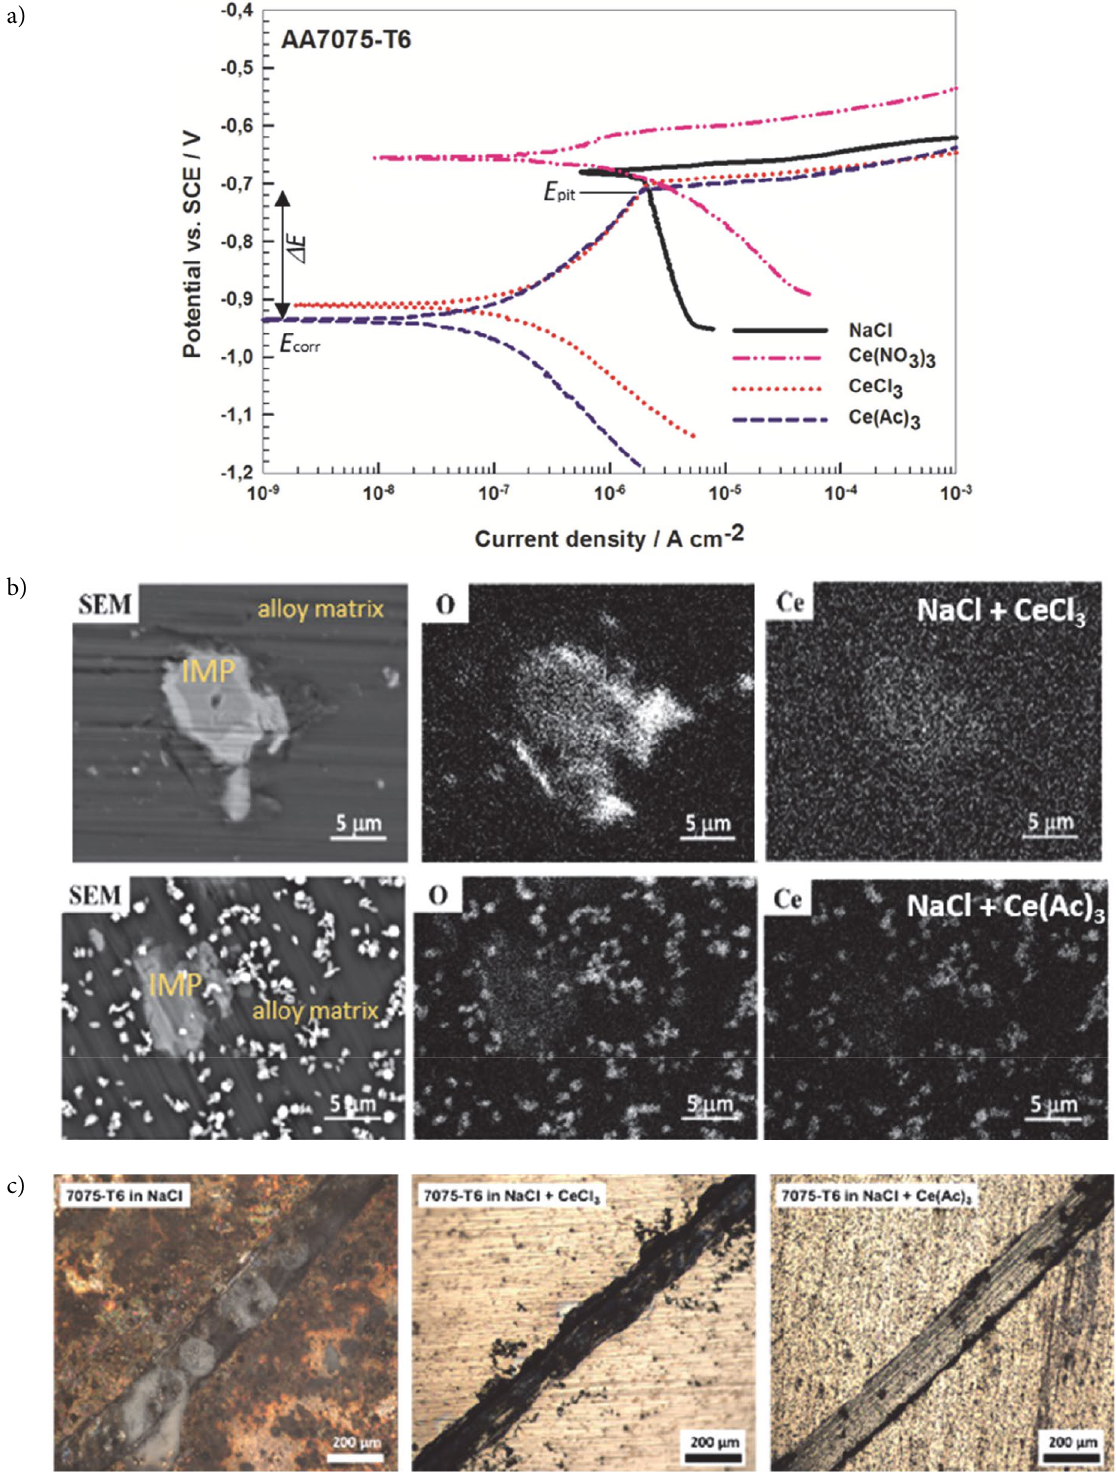
Figure 10. (a) Polarization curves recorded for aluminium alloy AA7075-T6 in 0.1 M NaCl solution with and without added 3 mM cerium(III) ni- trate, chloride and acetate salts. Corrosion potential ( E corr ), pitting potential ( E pit ) and the span of passivity region (∆ E ) are denoted. d E /d t =1 mV/s. ( Reprinted from the publication by P. Rodič, I. Milošev, J. Electrochem. Soc., 2016 , 163, C85 − C93 with permission from The Electrochemical Society. 66 ) (b) SEM images of AA7075-T6 immersed for 24 h in 0.1 M NaCl + 3 mM CeCl 3 and 3 mM Ce(Ac) 3 for 24 h and EDS mapping for O and Ce ele- ments.(c) Confocal microscope images of artificially made scratch on AA7075-T6 after 72 h immersion in 0.1 M NaCl and 0.1 M NaCl with added 3 mM CeCl 3 and 3 mM Ce(Ac) 3 . ( Reprinted from the publication by I. Milošev, P. Rodič, Corrosion, 2016 , 72, 1021 − 1034 with permission from NACE. 67 Milošev: Contemporary Modes of Corrosion Protection ...